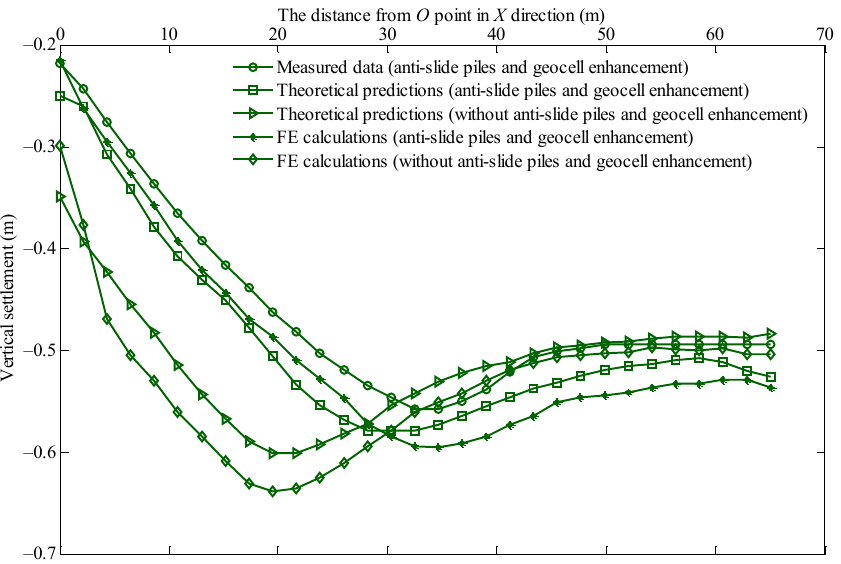
Figure 11. Vertical settlement of the top surface of the riverbank slope in the horizontal direction.